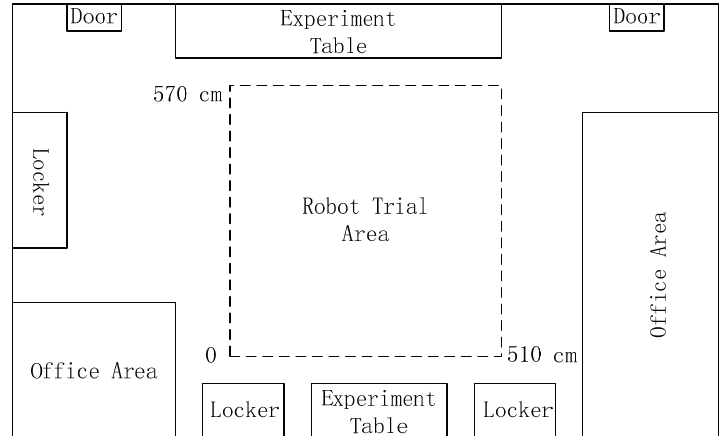
Figure 11. Robot trial environment in the real scene.